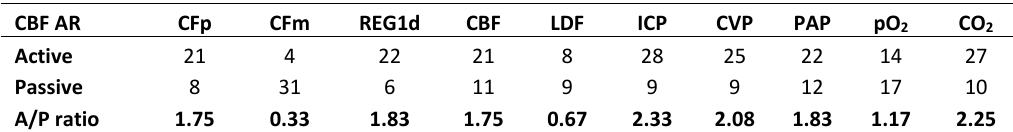
Table 2: Summary of CBF AR changes during challenges in PEEP group. CBF AR status was calculated as the relationship to SAP change. (See Table 1 for legend).